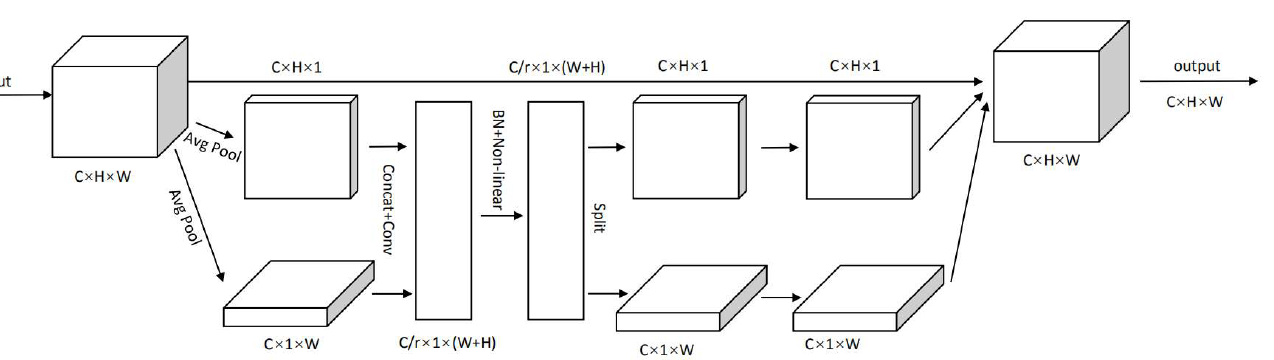
Figure 5. The network of CA.